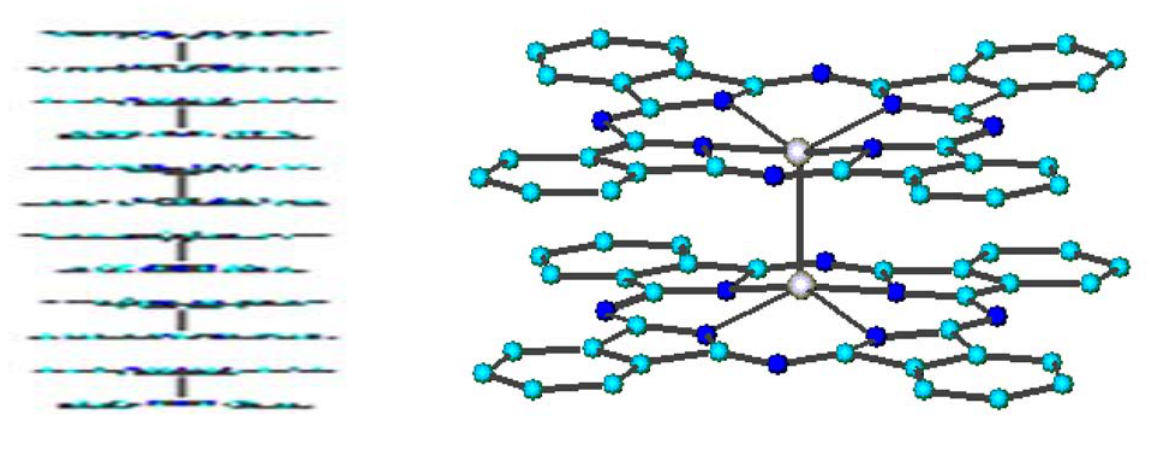
and its columnar 2